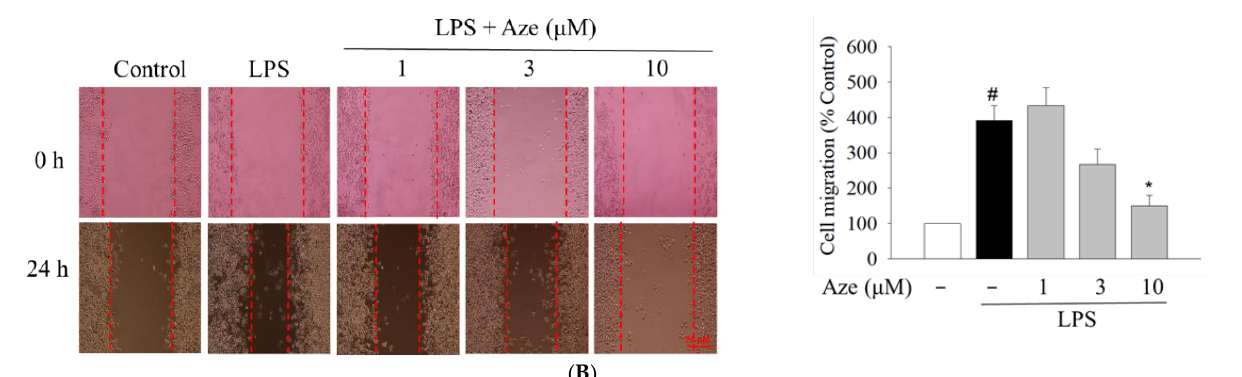
Figure 6. Aze diminished the LPS-stimulated cell migration in BV2 cells. Cells were co-treated with LPS (1 μg/mL) and a series of concentrations of Aze for 24 h. Control cells were treated with vehicle alone. The alterations in cell migration were assessed by transwell ( A ) and wound healing ( B ) assays, as described in the Materials and methods. Representative microscopic images are shown (scale bar, 20 μm). Data are presented as the mean ± SEM from three independent experiments. # p < 0.05 and * p < 0.05 vs. vehicle-treated control and LPS-treated cells, respectively.